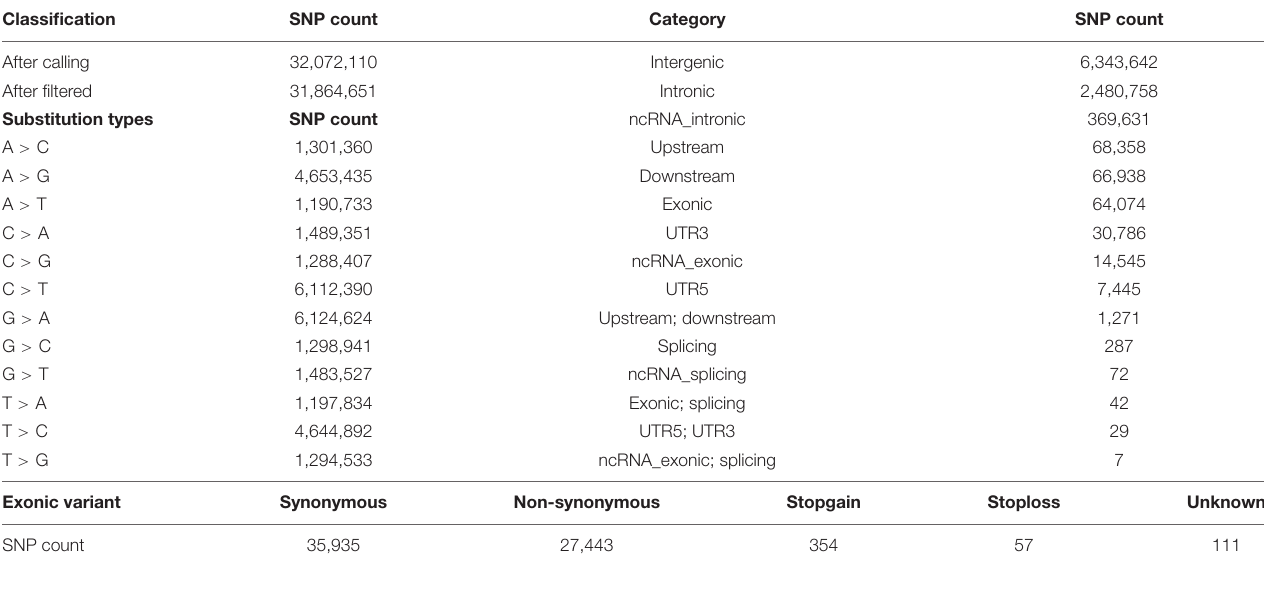
TABLE 1 | SNP statistical information of Jining Gray